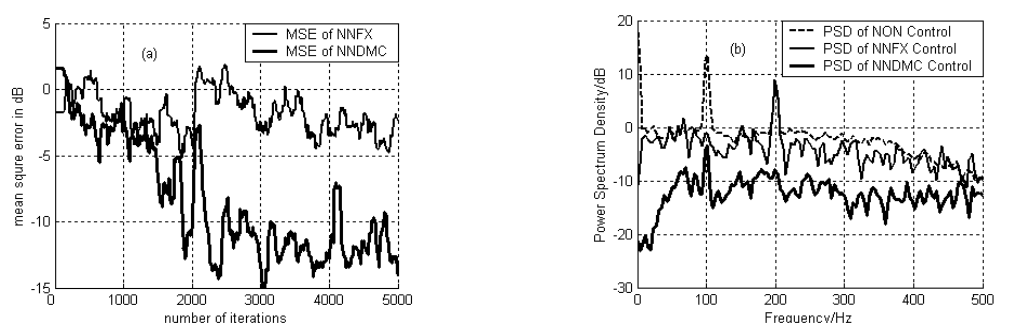
Fig. 6. (a) The error curves of proposed nonlinear DMC algorithm and NN-based nonlinear FXLMS algorithm for ANC system with off-line secondary path modeling. (b) Power spectrum of active noise canceling errors for ANC system with off-line secondary path modeling. The thin line shows the results from NN-based controller, the thick line shows the results from nonlinear DMC controller, and the dished line shows the results when ANC is turned off.